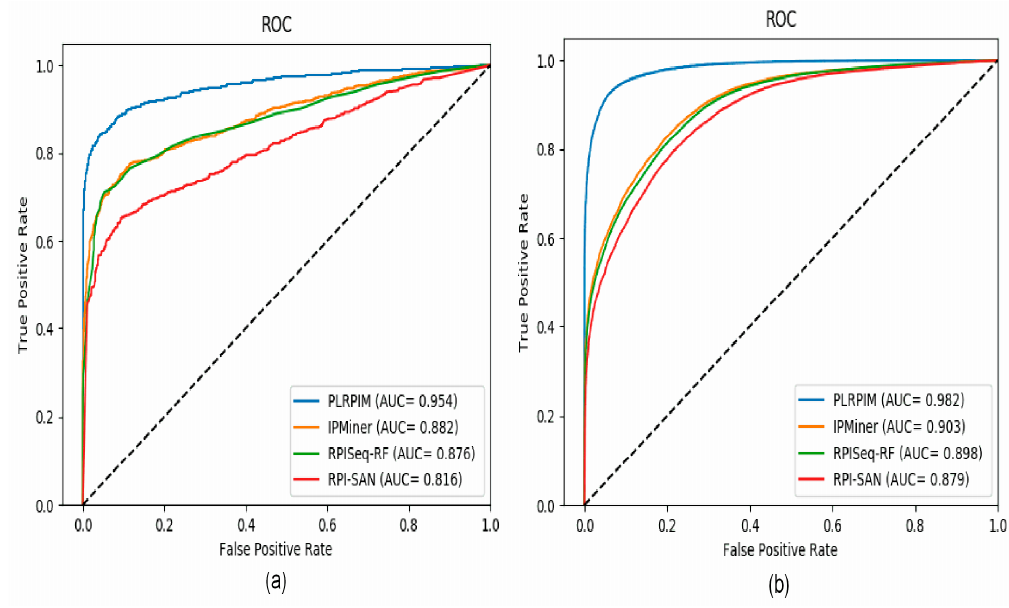
Figure 5. ROC curves for PLRPIM, IPMiner, RPISeq-RF, and RPI-SAN on ( a ) Arabidopsis thaliana and ( b ) Zea mays datasets.